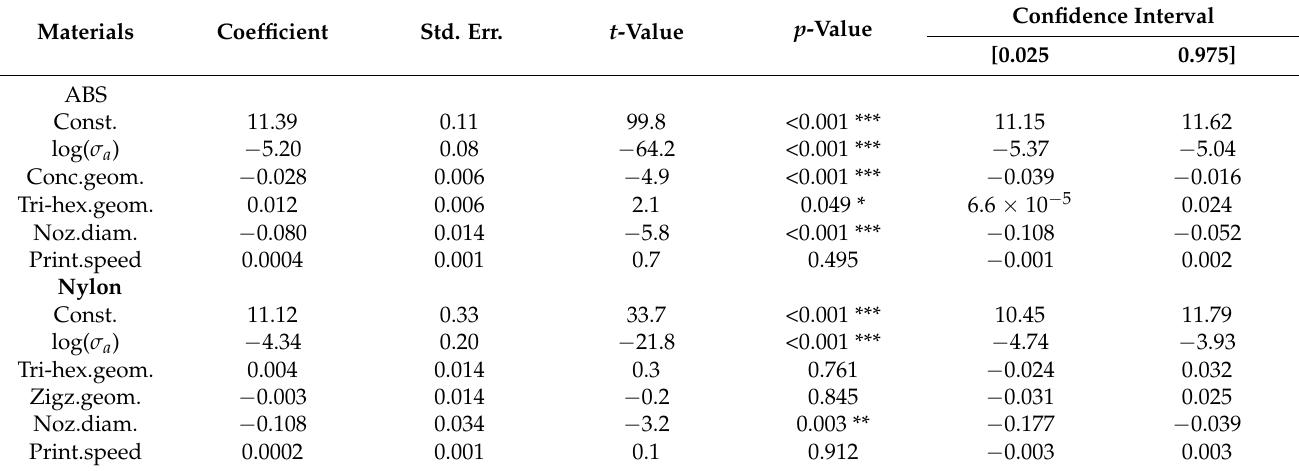
Table 8. Multiple linear regression results for fatigue life in terms of logarithmic